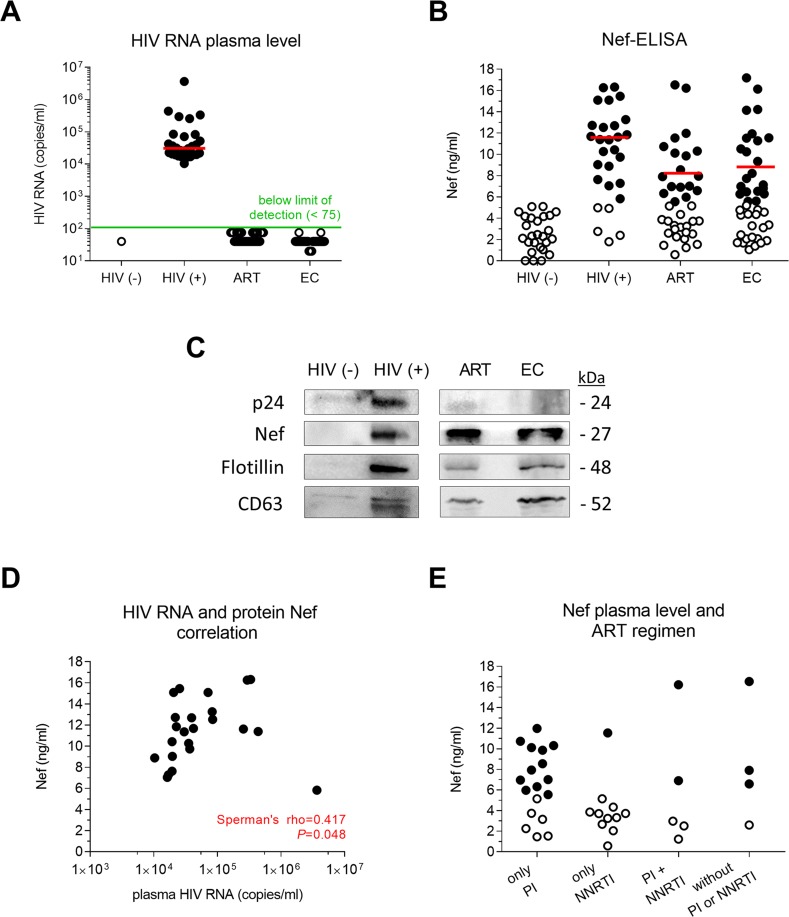
Viral protein Nef was detected in plasma of approximately half of aviremic HIV-infected subjects.Red lines represent the median value. (A) Real-time PCR detection of plasma HIV RNA levels in study participants. Full circles represent exact plasma HIV RNA levels, while empty circles represent the limit of detection of the assay used to measure individual’s plasma HIV RNA. (B) Detection of plasma Nef levels in study participants using optimized HIV Nef ELISA. Full circles represent measured plasma Nef levels, while empty circles represent background values. The background level of the HIV Nef ELISA, determined by ROC curve analysis, was 5.46 ng/ml. (C) Immunoblot of lysed viruses and/or extracellular vesicles enriched from representative plasma samples of the HIV-negative, non-controller, ART-suppressed and elite controller groups. Antibodies directed against HIV proteins p24 and Nef, and against extracellular vesicle markers flotillin and CD63, were used. (D) Correlation between plasma HIV RNA and detectable Nef levels in non-controllers. (E) Plasma Nef levels in aviremic ART-suppressed subjects treated with various ART regimens. Full circles represent measured plasma Nef levels, while empty circles represent assay background values. HIV (-), HIV-negative; HIV (+), non-controller; ART, ART-suppressed; EC, elite controller; PI, protease inhibitor-based therapy; NNRTI, non-nucleoside reverse transcriptase inhibitor-based therapy.